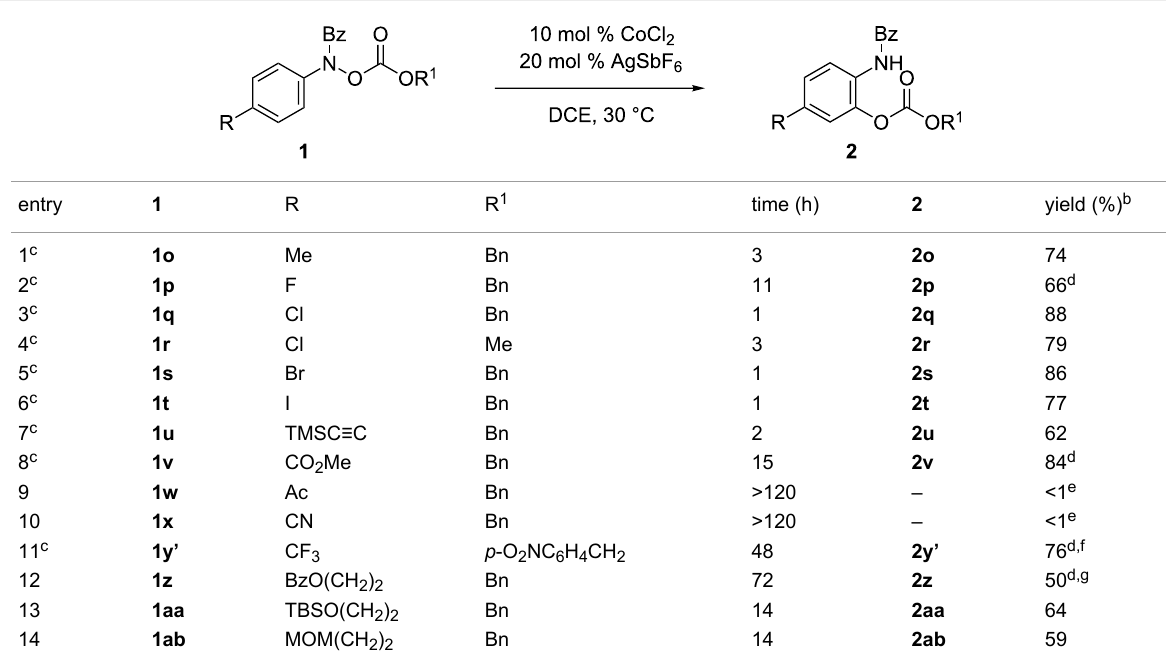
Table 4: Co-catalyzed reaction of N -alkoxycarbonyloxyanilines 1o–ab .